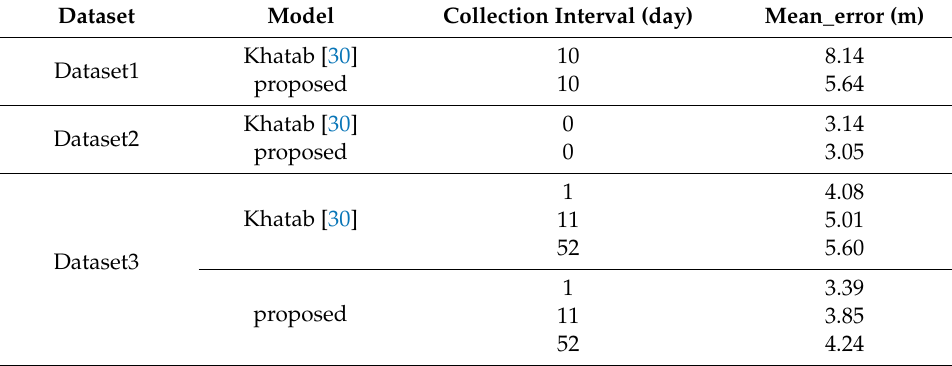
Table 7. The average positioning errors between our proposed algorithm and Khatab’s